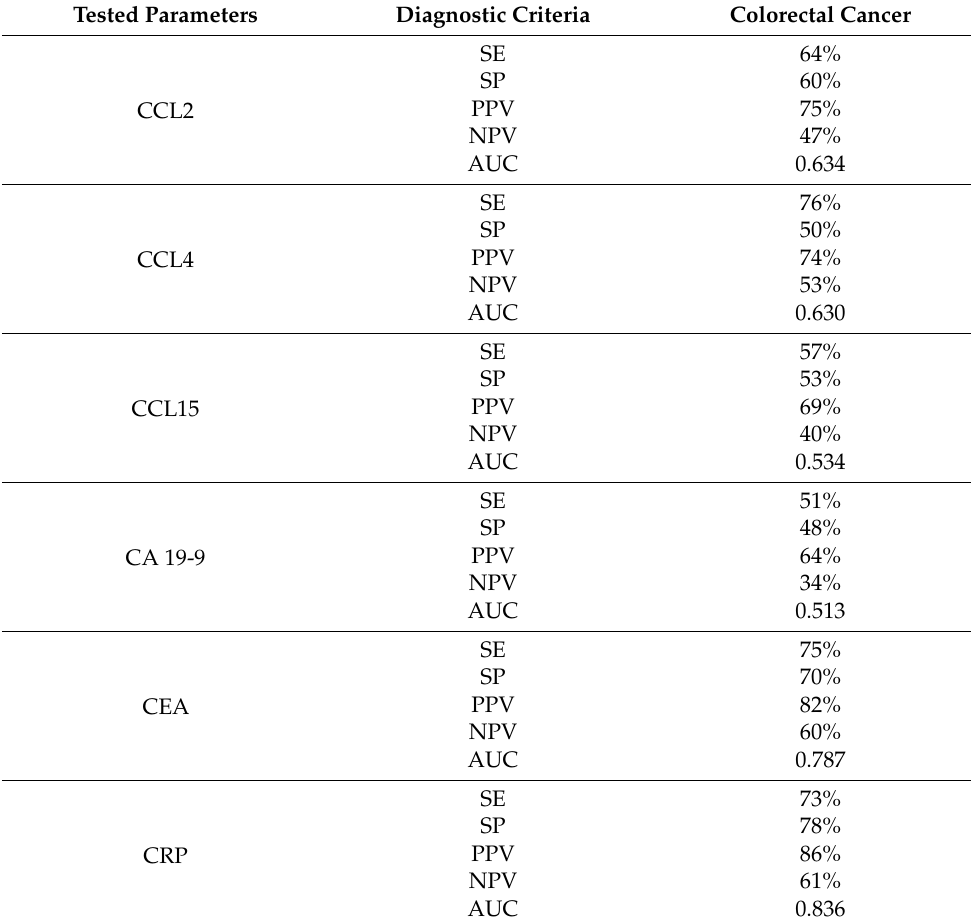
Table 5. Diagnostic criteria of tested parameters in patients with colorectal cancer. Tested Parameters Diagnostic Criteria Colorectal